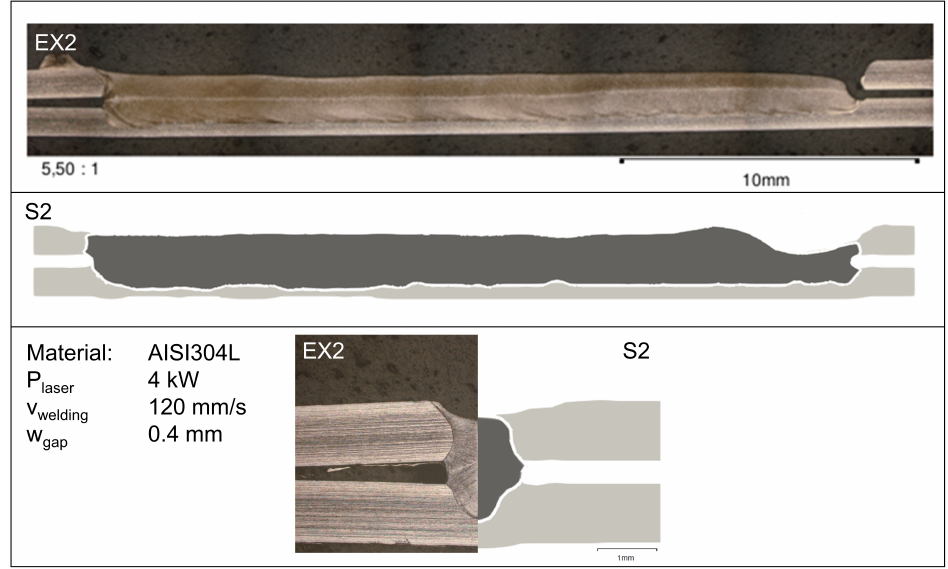
Figure 5. A comparison of experiment EX2 and simulation S2 (model validation).